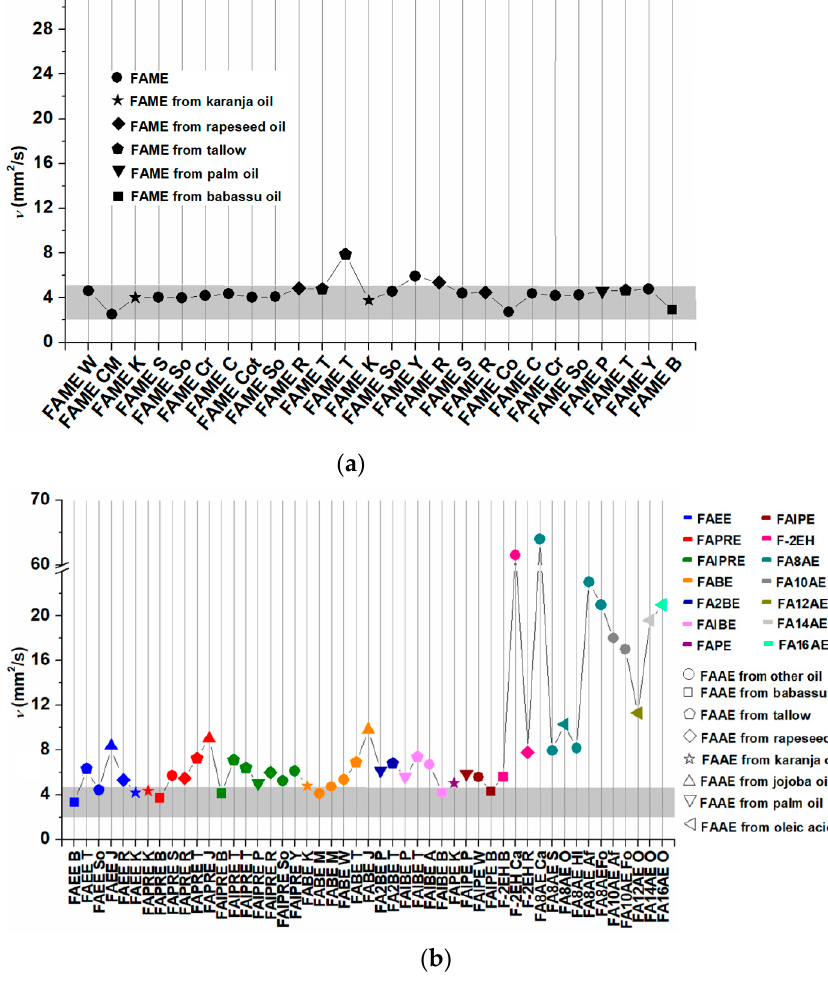
Figure 2. Literature kinematic viscosities of different fatty acid alkyl esters: ( a ) FAME from different triglyceride sources, ( b ) fatty acid alkyl (C 2+ ) esters from different triglyceride sources (values and corresponding references are given in Table 2).